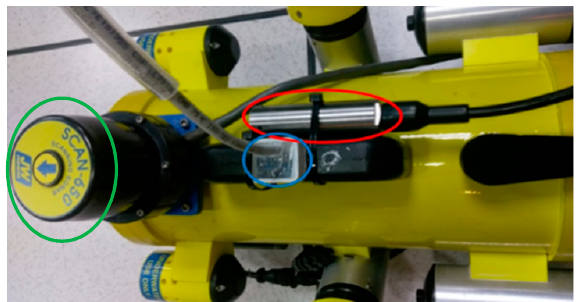
Figure 1. The remotely operated vehicle (ROV) and experimental sensors. The red oval is a water pressure gauge. The blue oval is an inertial measurement unit (IMU) sensor. The green oval is the scanning sonar.